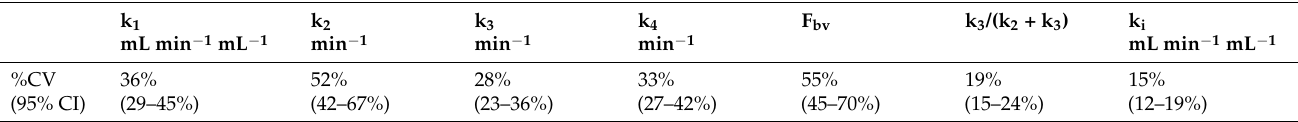
Table 1. Precision of [ 18 F] sodium fluoride PET kinetic parameters [43] are listed in this table. %CoV results for SUV were 11% (9–14%). %CV: coefficient of variation; 95% CI: 95% confidence